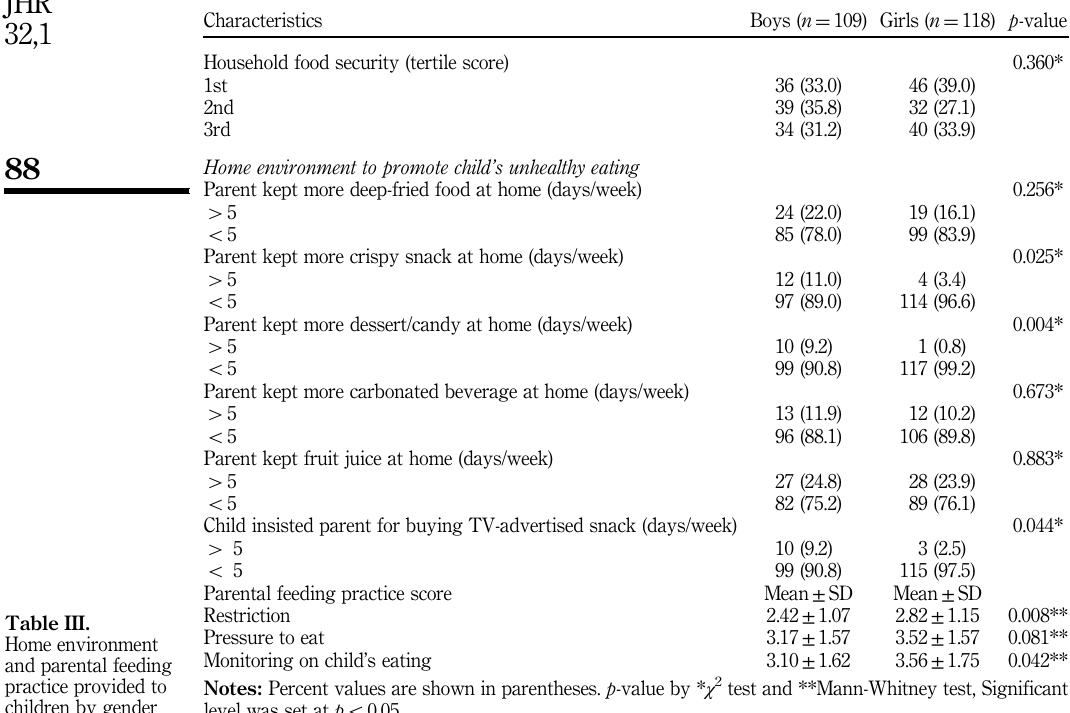
Table III. Home environment and parental feeding practice provided to children by